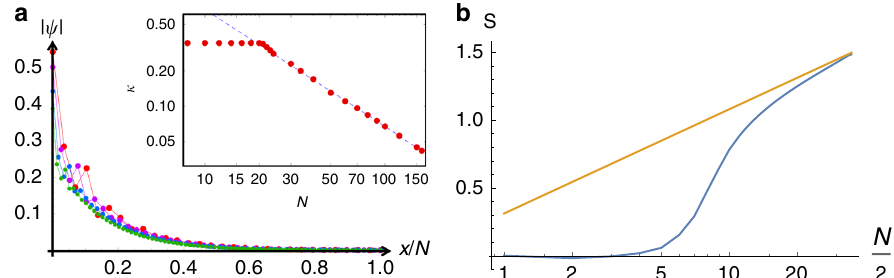
Fig. 3 Anomalous scaling behaviors of the critical non-Hermitian skin effect. a Scale-free open-boundary skin eigenstate of the largest Im ½ E (cid:2) eigenenergy of H 2-chain at system sizes N = 20, 40, 60, and 80 (red, purple, blue, green, respectively). Its rescaled pro fi le, despite decaying exponentially rather than power-law, remains invariant across different N . This scale invariance persists in the N > 20 regime, and is due to the N − 1 decay (dashed line) of the inverse skin depth (red dots), as plotted in the inset. Parameters follow Fig. 2 ’ s, except with t 0 = 10 − 3 . b Entanglement entropy S (blue) of a half- fi lled open- boundary H 2-chain at odd system sizes N , with real-space cut at b N δ = − δ = 0.25. It saturates near zero in the gapless decoupled small N regime, but scales like (cid:3) 1 a b